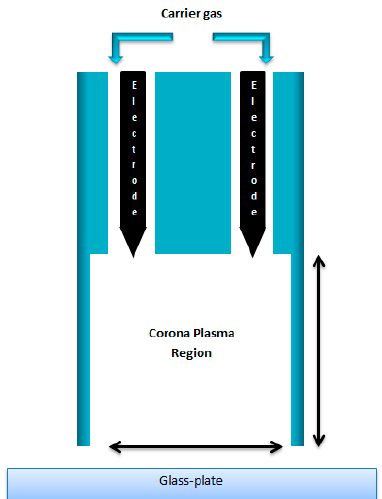
Figure 2. Schematic of the Corona plasma discharge device applied for deposition of laccase coatings.